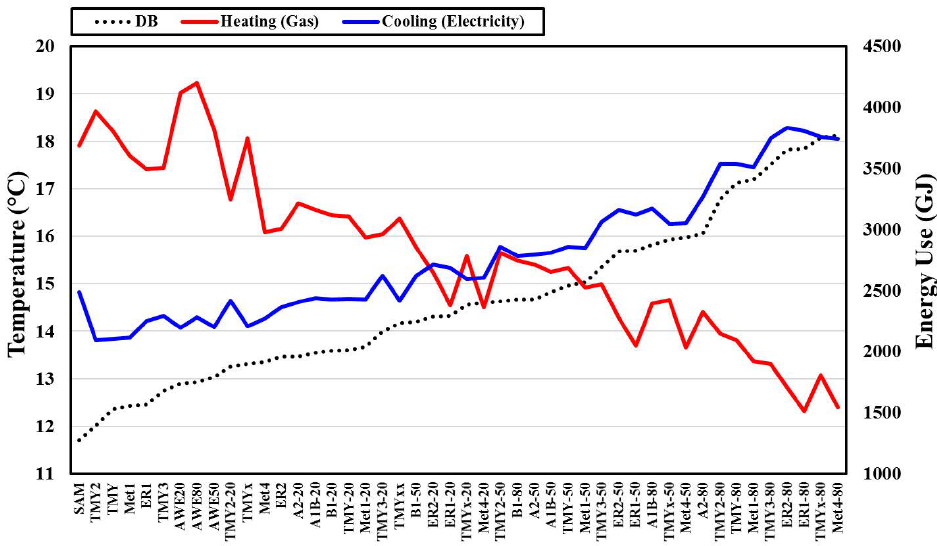
Figure 2. Results of dry bulb temperature and direct normal irradiation for each of the current and future TMY files and their associated heating and cooling energy use from EnergyPlus modeling of the case